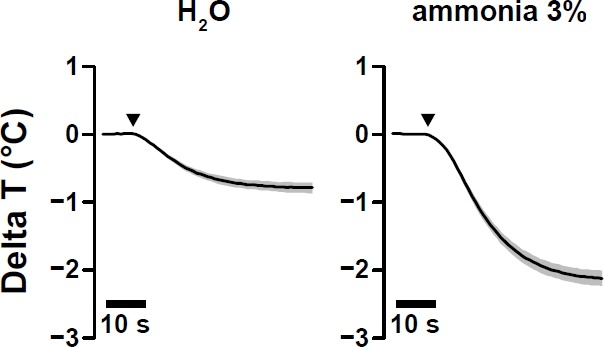
Ammonia increases the evaporative cooling effect of water.A temperature probe (Almemo Pt100, ZA9030-FS2) was dipped into water or 3% ammonia and immediately removed.The temperature of the probe was recorded at 1 Hz during 10 s before and 50 s after dipping. The arrowhead indicated the time of dipping into the solution. Traces show temperature changes (mean±SEM; n = 10-11) relative to the mean room temperature before dipping. The drop in temperature reflects evaporative cooling. This phenomenon is more pronounced after dipping the probe in ammonia than in water.